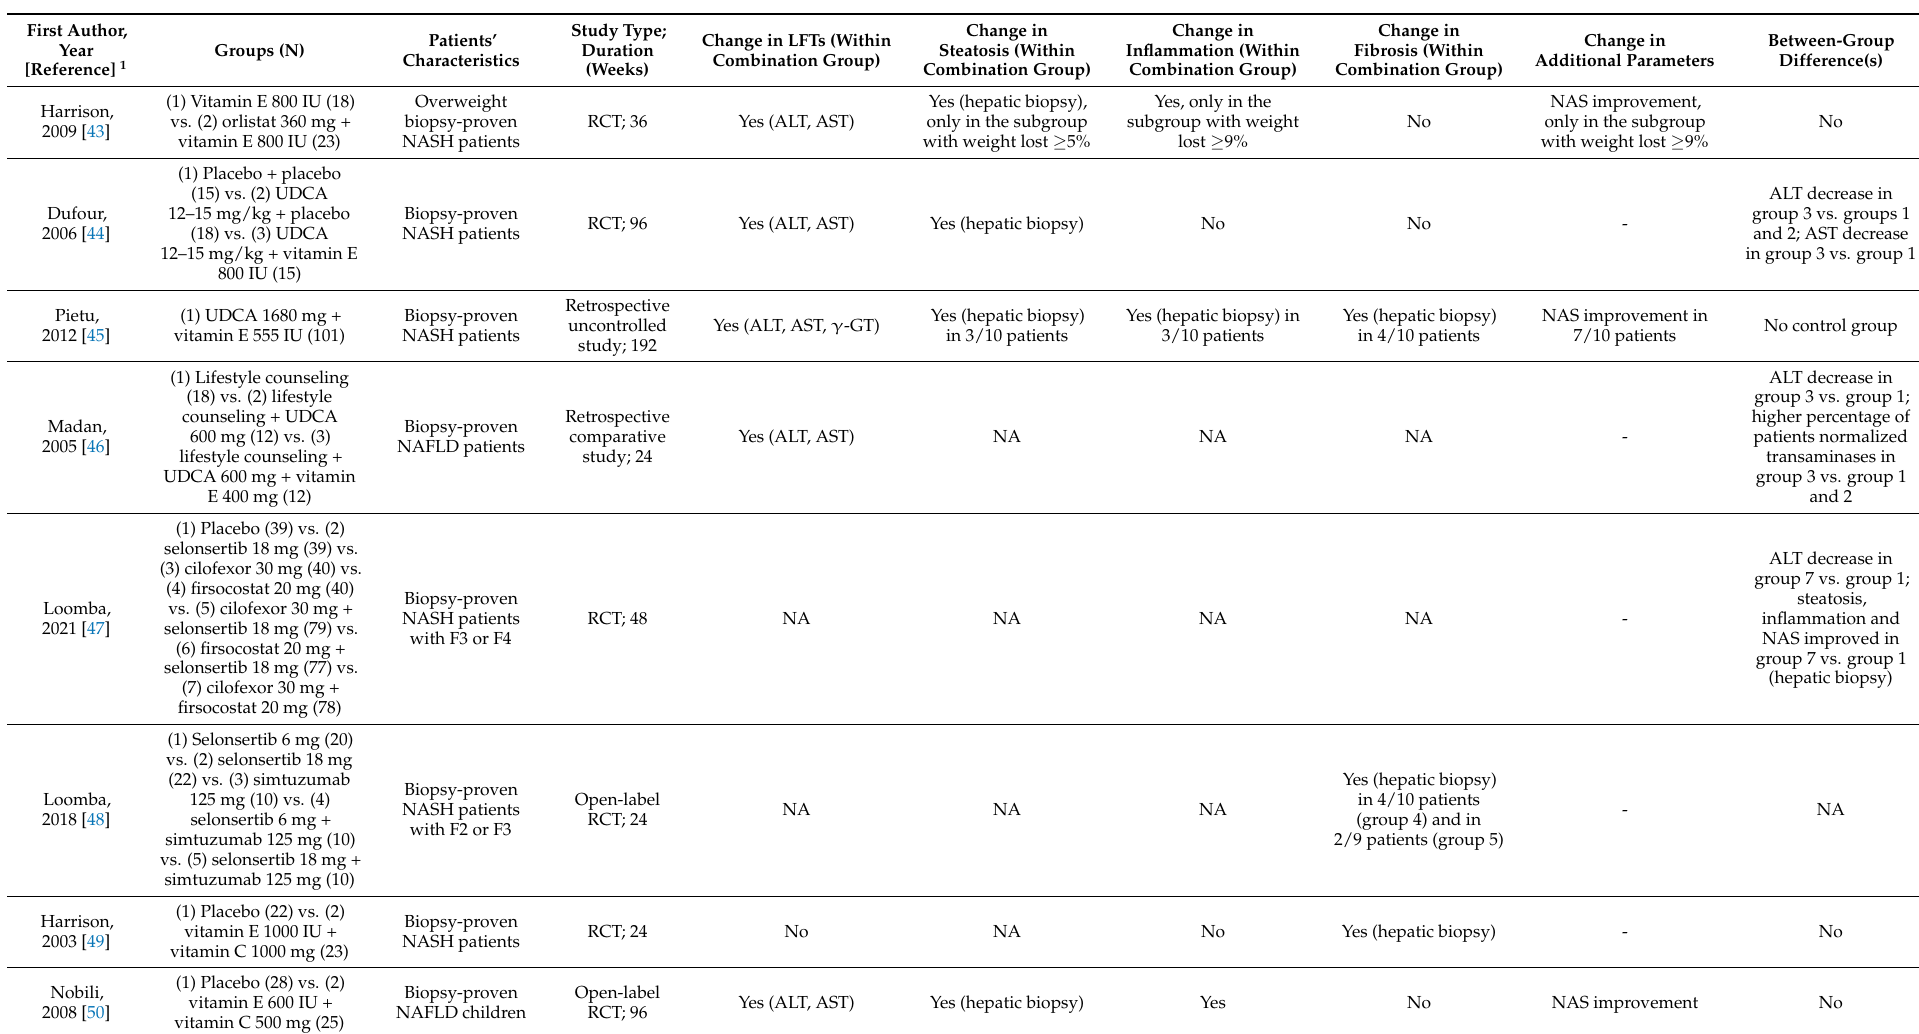
Table 1. Clinical studies having evaluated combination therapies in patients with